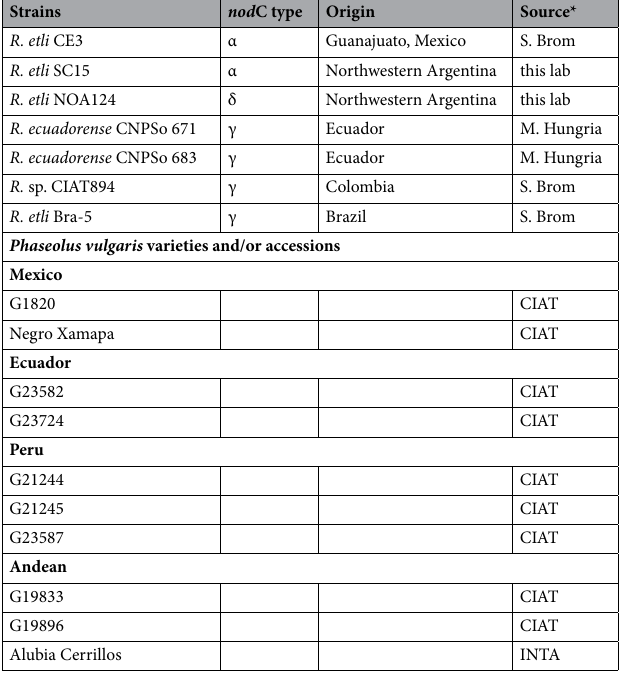
Table 1. Bean rhizobia and plant material. *CIAT, Centro Internacional de Agricultura Tropical; Cali, Colombia; S. Brom, Centro de Ciencias Genómicas, Cuernavaca, Mexico; M. Hungría, EMBRAPA Soja, Londrina, Brazil; INTA, Estación Experimental Agropecuaria Salta, Salta, Argentina.